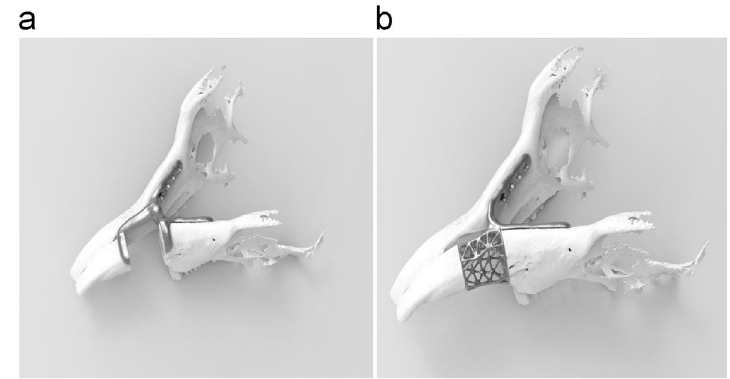
Fig. 1 Design of bone resection guides and implants. a Bone resection guide; b implant